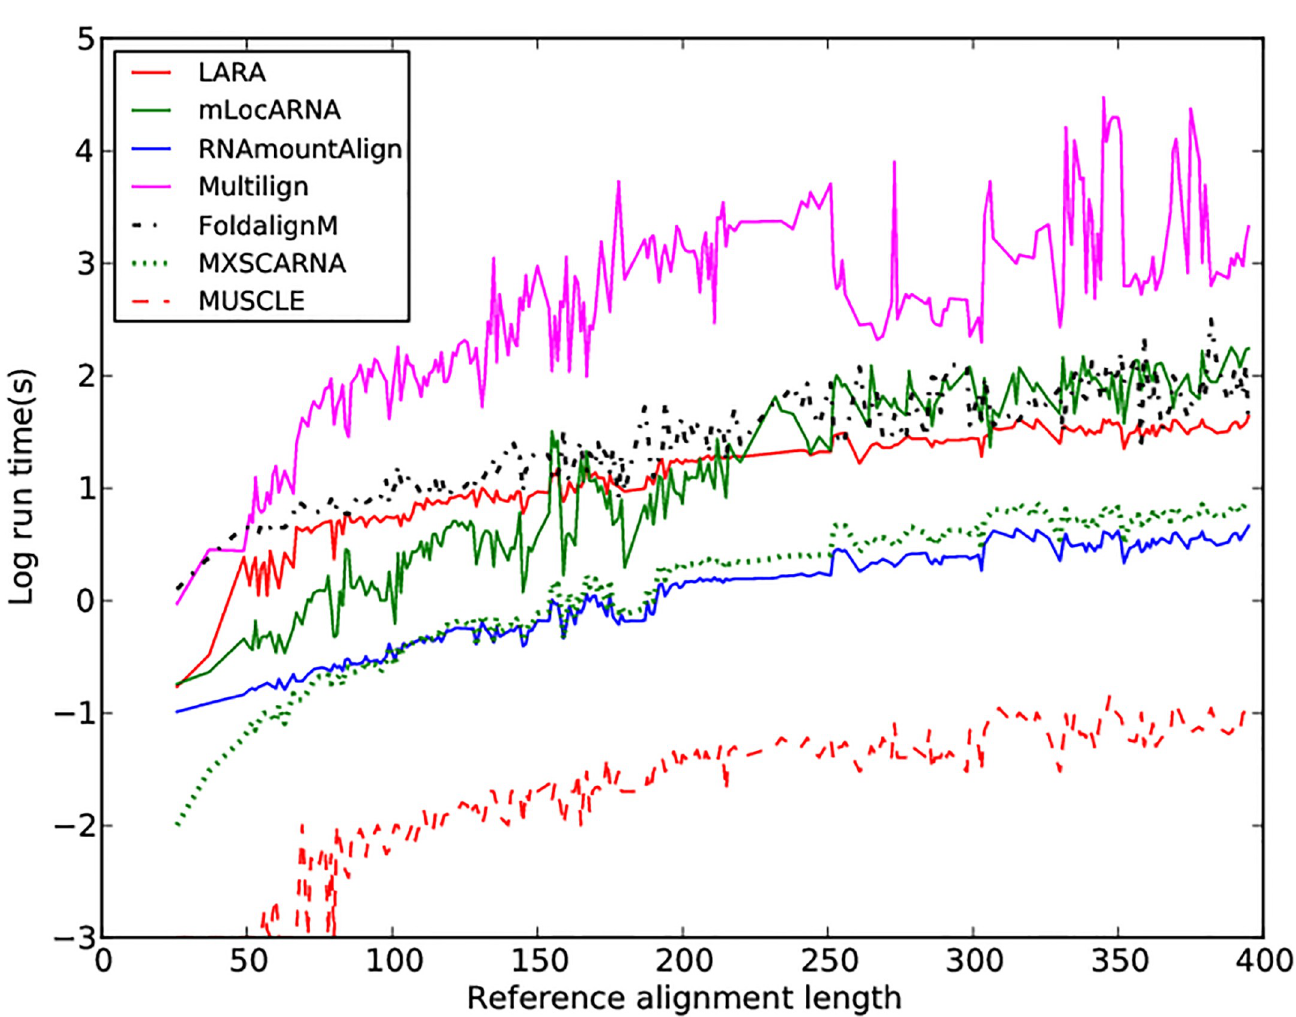
Fig 8. Run time of multiple global alignment for RNAmountAlign , mLocARNA , LARA , FoldalignM , Multilign , MXSCARNA and MUSCLE . Log run time is as shown a function of reference alignment length for K5 alignments in BRAliBase 2.1 . For the structural multiple alignment algorithms benchmarked on this data, RNAmountAlign and MXSCARNA both appear to have the fastest runtime, while RNAmountAlign is faster than MXSCARNA for pairwise